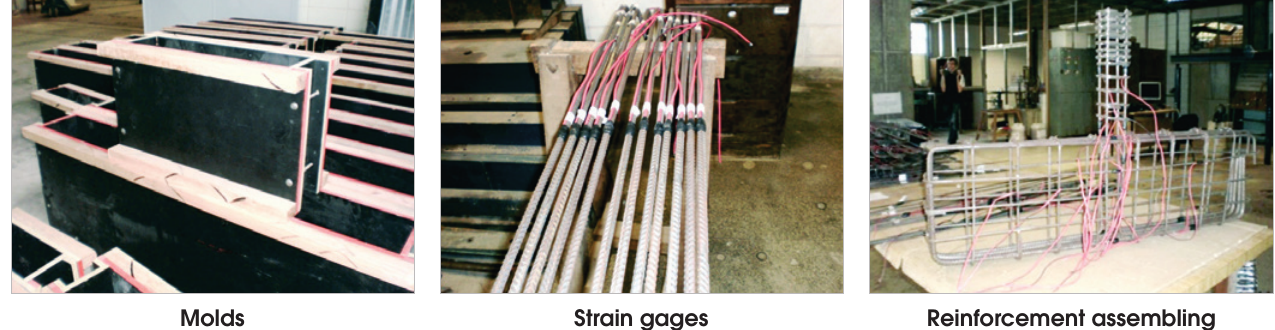
Molds Strain gages Reinforcement Initial stages of construction of experimental models